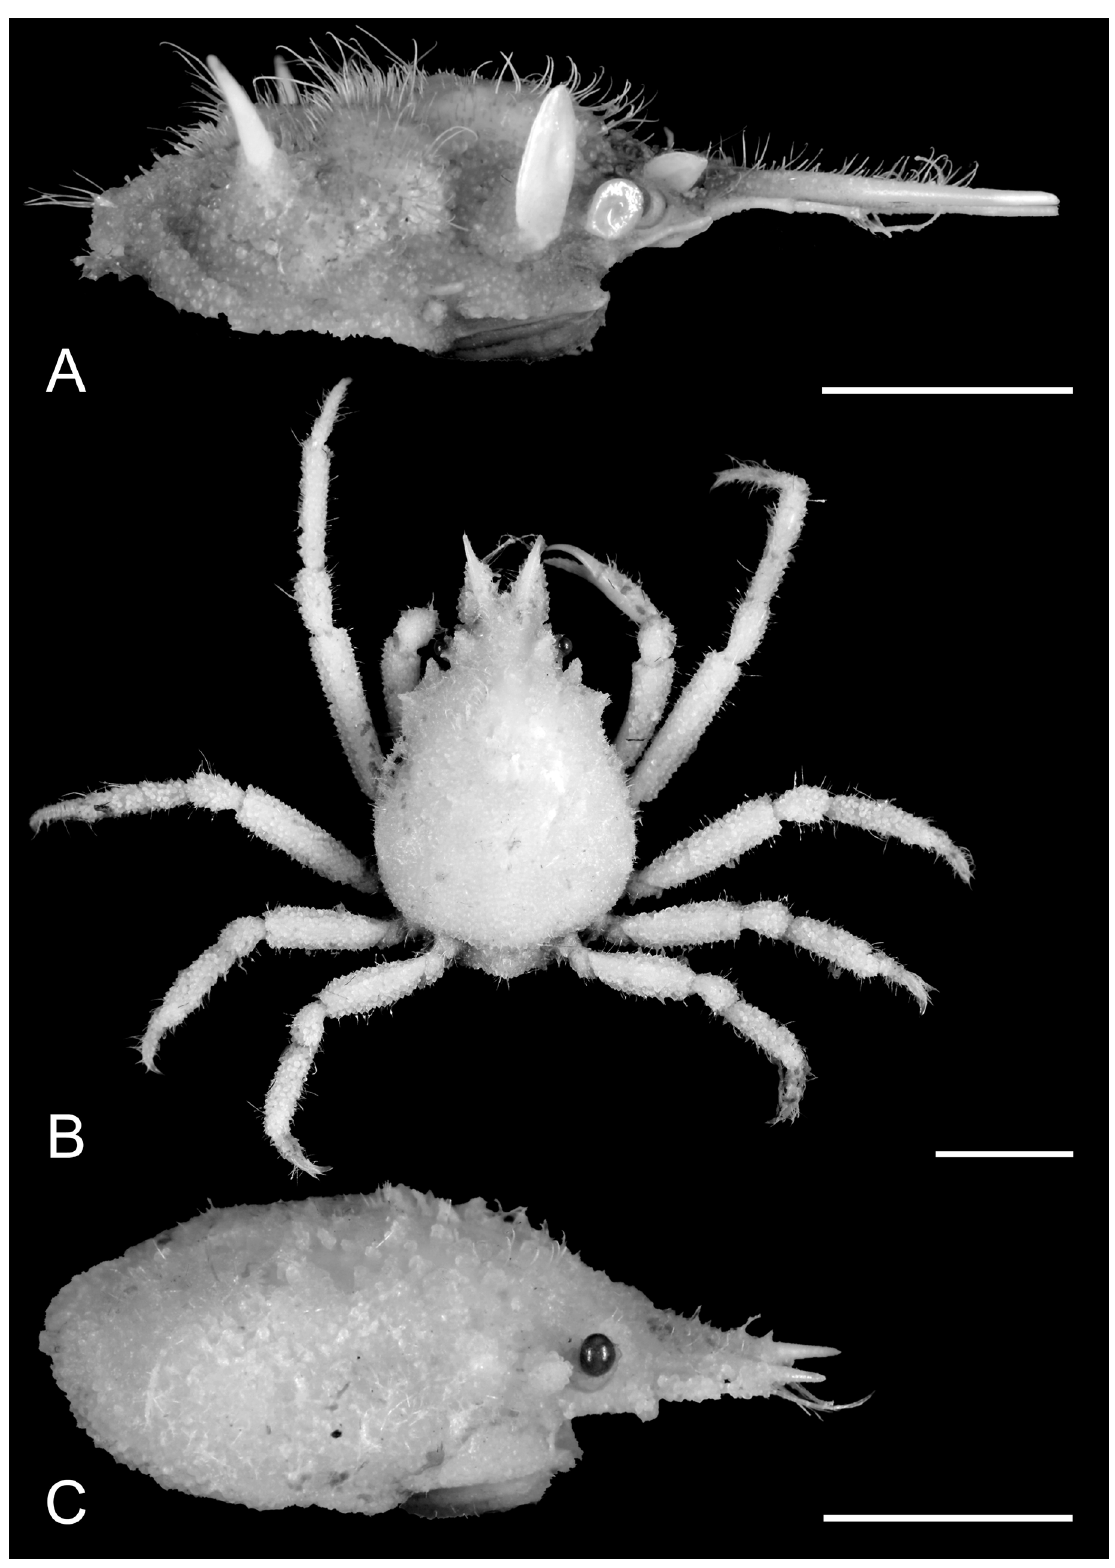
Fig. 8. A . Rochinia kotakae Takeda, 2001, ovigerous ♀ (14.0 × 9.1 mm) (ZRC 2016.0079), South China Sea, lateral view of carapace. B – C . Rochinia sp., ♀ (7.6 × 5.3 mm) (ZRC 2016.0551), South China Sea. B . Overall dorsal view. C . Lateral view of carapace. Scale bars: A = 5 mm; B–C = 2.5